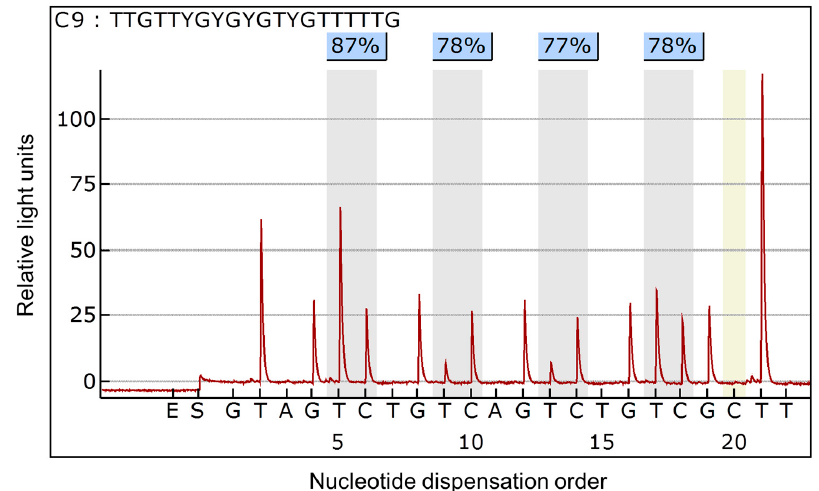
Figure 1. Representative pyrogram of DNA methylation analysis of the NT5E gene. The sequence at the top of the pyrogram represents the sequence to be analyzed. Gray shadowing highlights the analyzed CpG sites. The thymine (T) and cytosine (C) peaks indicate unmethylated and methylated C, respectively. Percentage values over the C base are the percent of gene methylation at each site which is defined as the percent of C base. The yellow area indicates the portion of the C added to verify complete conversion of unmethylated C to T.